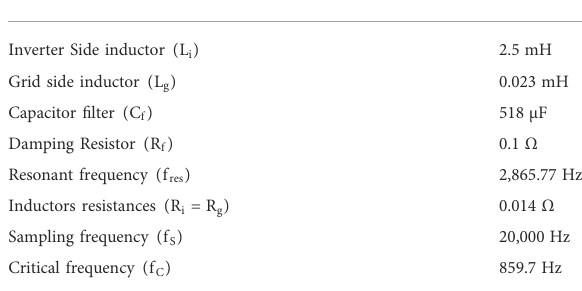
TABLE 6 LCL fi lter